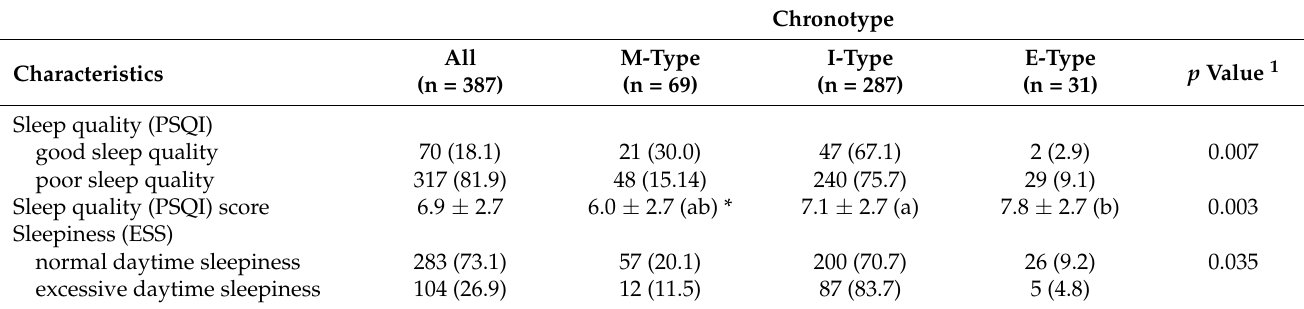
Table 4. Sleep patterns of the study participants (n =